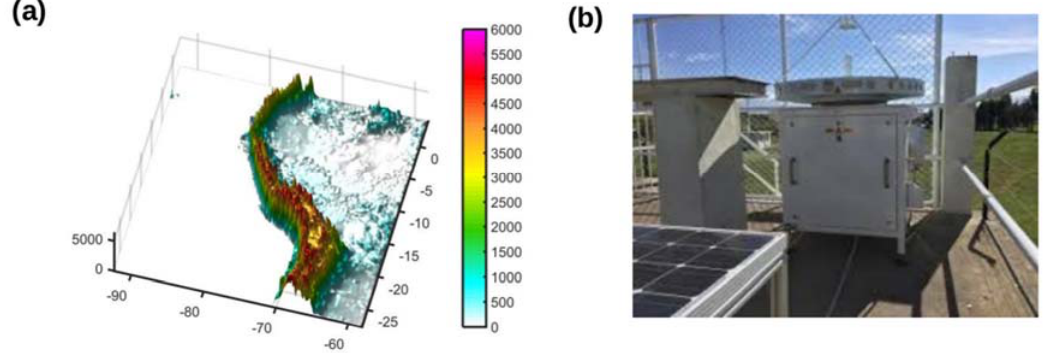
Figure 1. ( a ) Conceptual model of the main components of the SALLJ system at east of the Andes cordillera. ( b ) Magnetron based pulsed Ka-Band Doppler radar MIRA-35c has been installed in the Huancayo observatory since 2015.